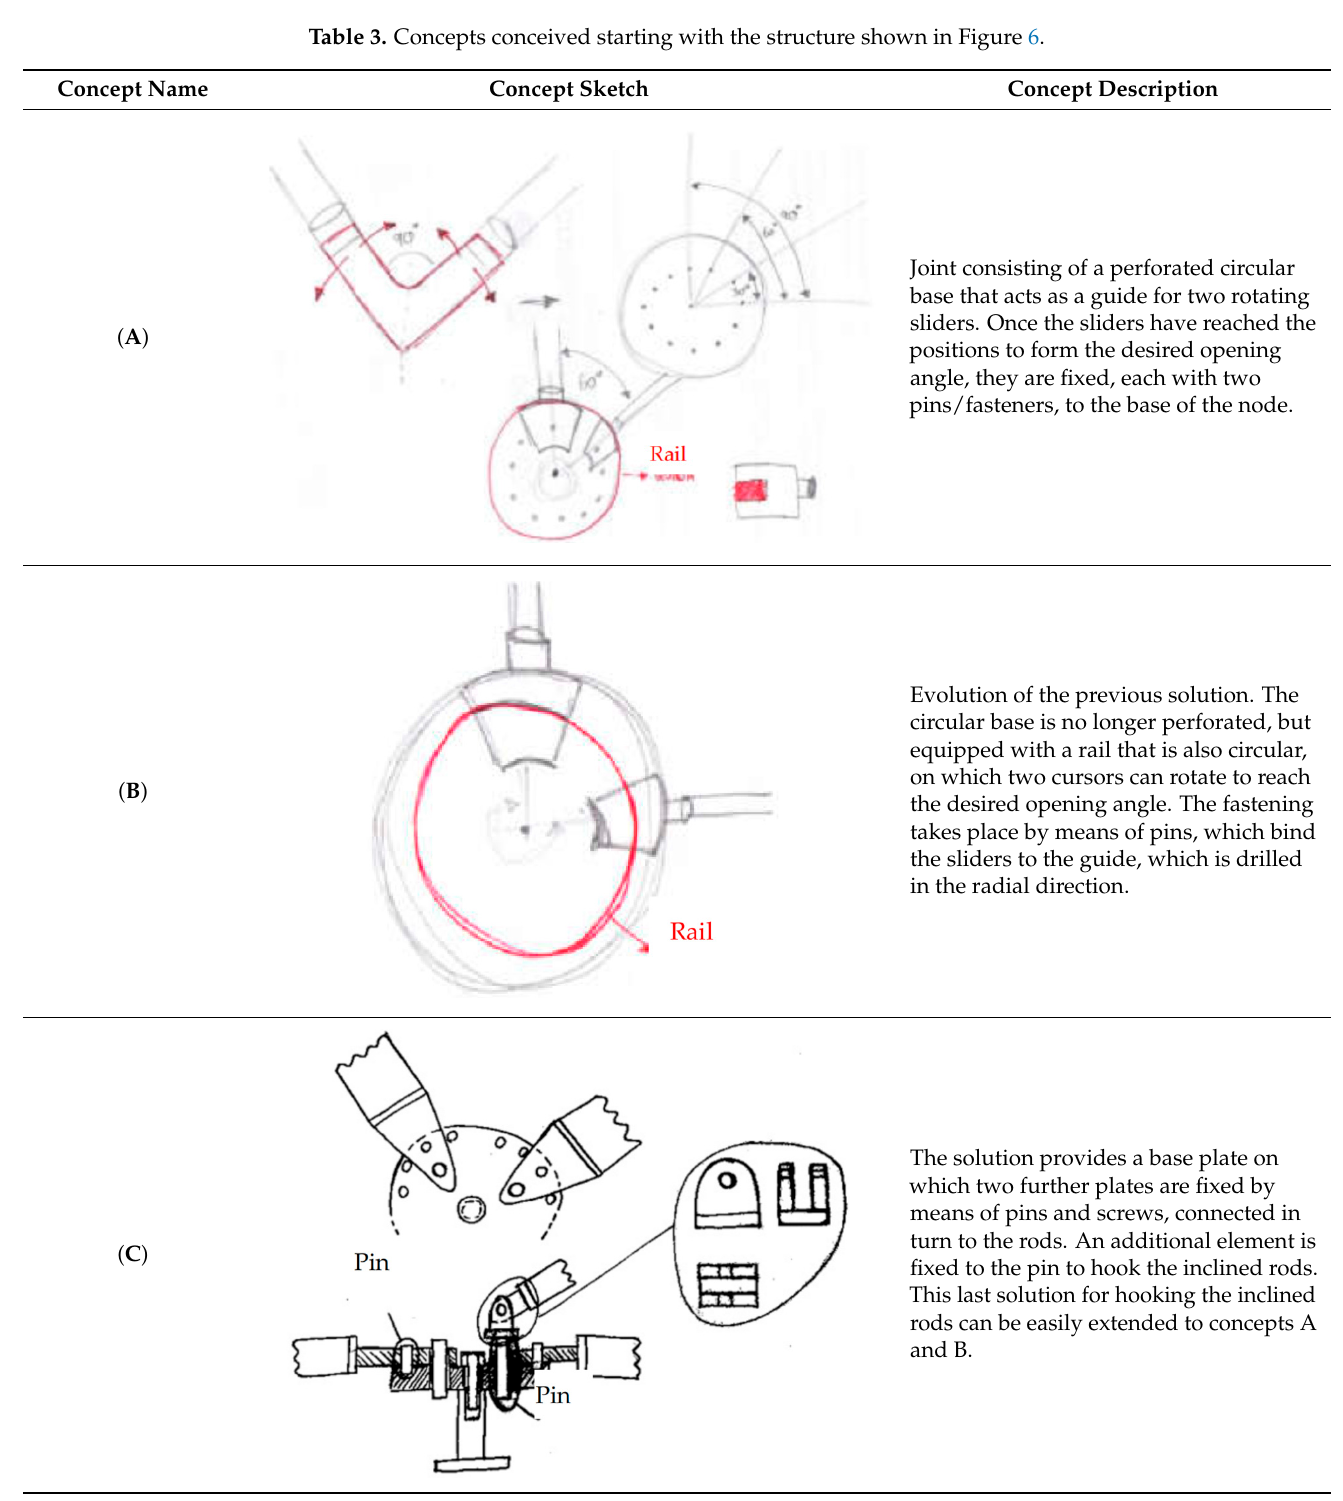
Table 4. Concepts devised starting with the patents and commercial elements referred to in Section